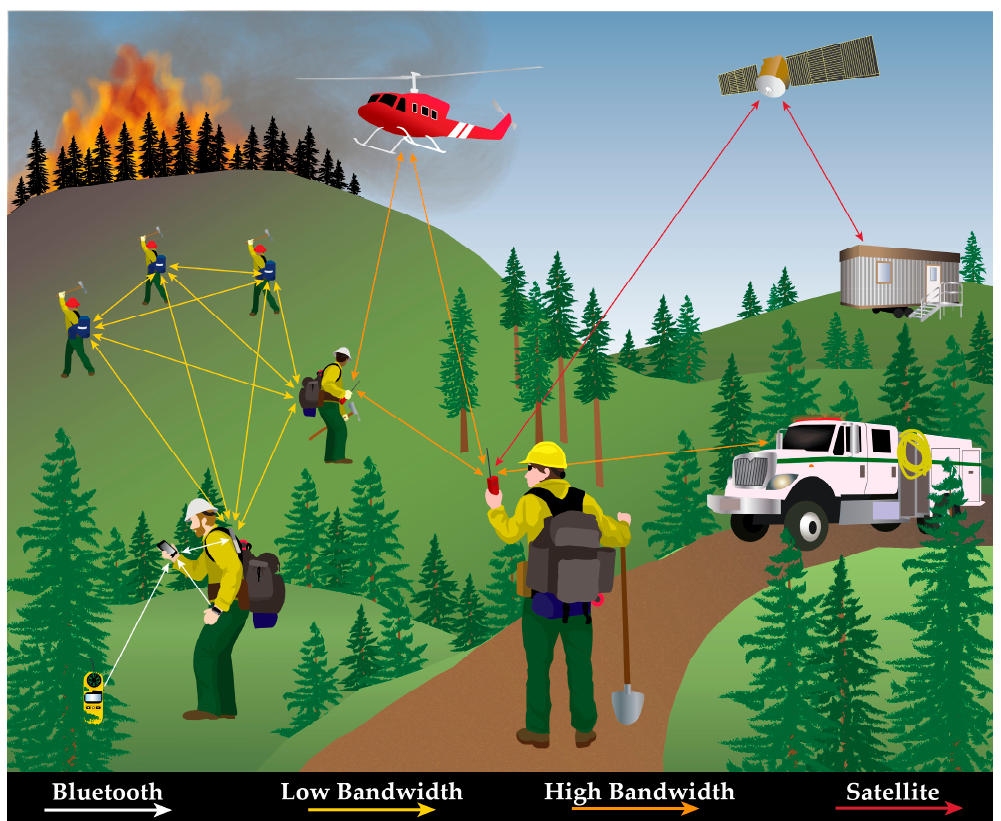
Figure 16. Hierarchical approach to location and data sharing in wildland firefighting. Smartphones serve as hubs for Bluetooth, BLE, or ANT devices such as an environmental sensor (bottom left) and wearable activity-monitoring devices on individuals. These data are processed locally on phones and summary data are transmitted via miniaturized radios such as goTenna, first by Bluetooth, BLE or ANT to the radio device, and then by radio frequency to other crew members. Crew bosses at a higher level of supervision receive data on advanced digital radios with higher bandwidth (and cost). For emergency alerts that require complete connectivity independent of a local network, and for the highest level of Incident Command, devices with two-way satellite data transfer are used.